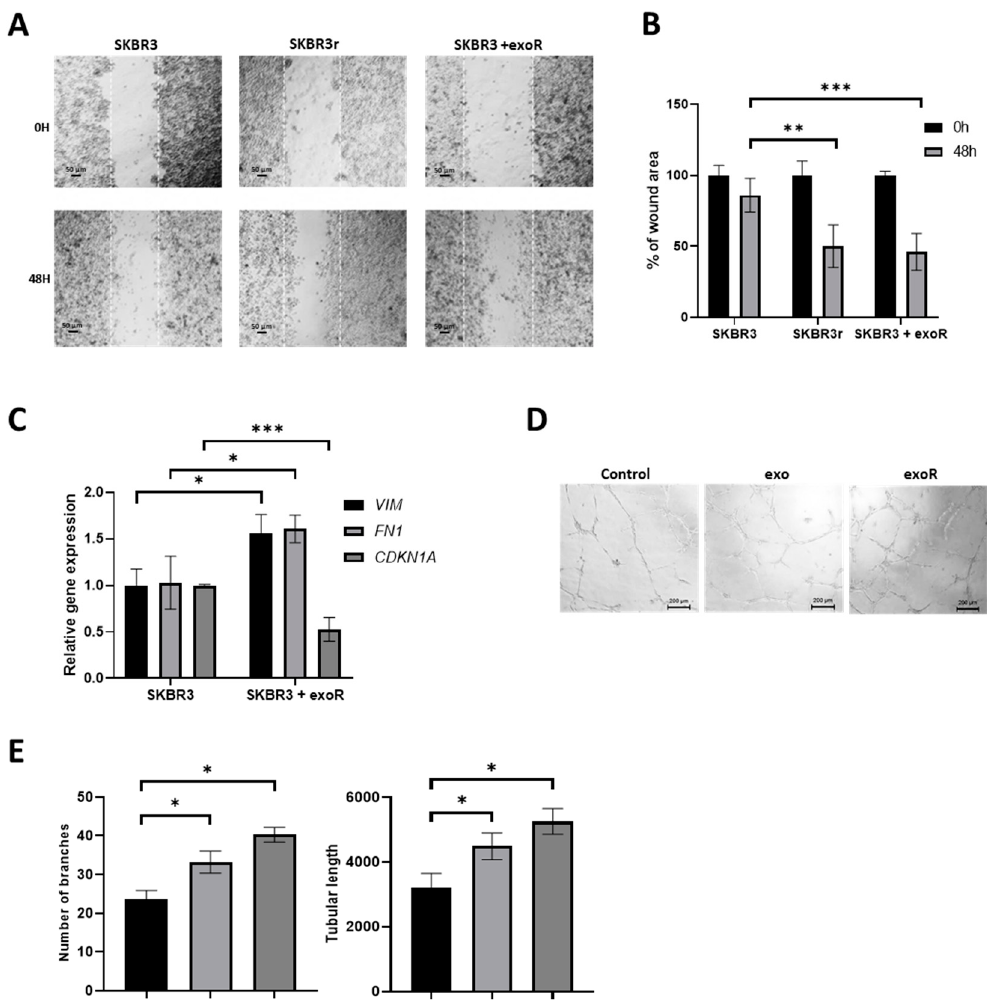
Figure 6. Effects of exosomes in cell migration and angiogenesis. ( A ) Representative images of wound-healing cell migration assay of SKBR3, SKBR3r, and SKBR3 co-cultured with exosomes from SKBR3r (exoR). Magnification: 10 × . ( B ) Quantification of the wound remaining area at 0 and 48 h. ( C ) Expression of EMT markers (VIM and FN1) and miR-146a-5p target CDKN1A, measured via RT-qPCR after co-culture of SKBR3 with exoR. GAPDH was used as endogenous mRNA gene, and